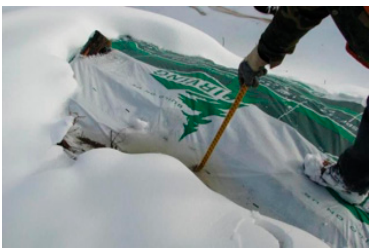
Figure 5. Plastic-based tarps after six months.